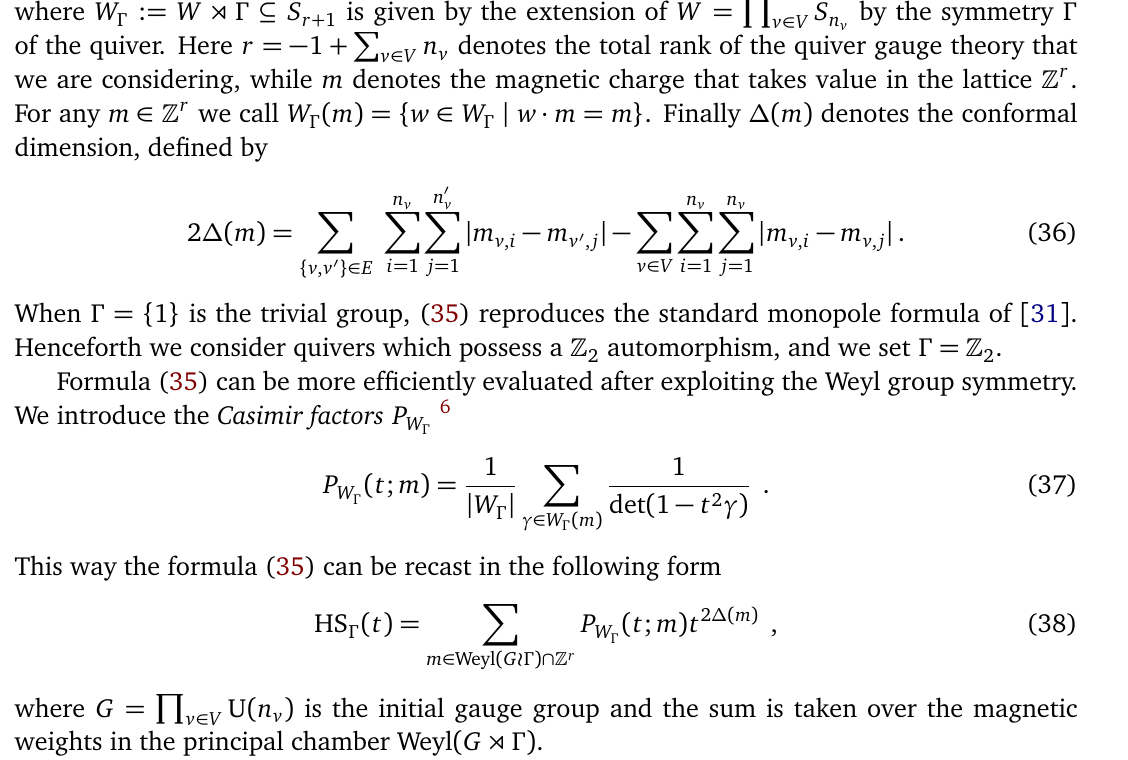
action on the legs of the 2